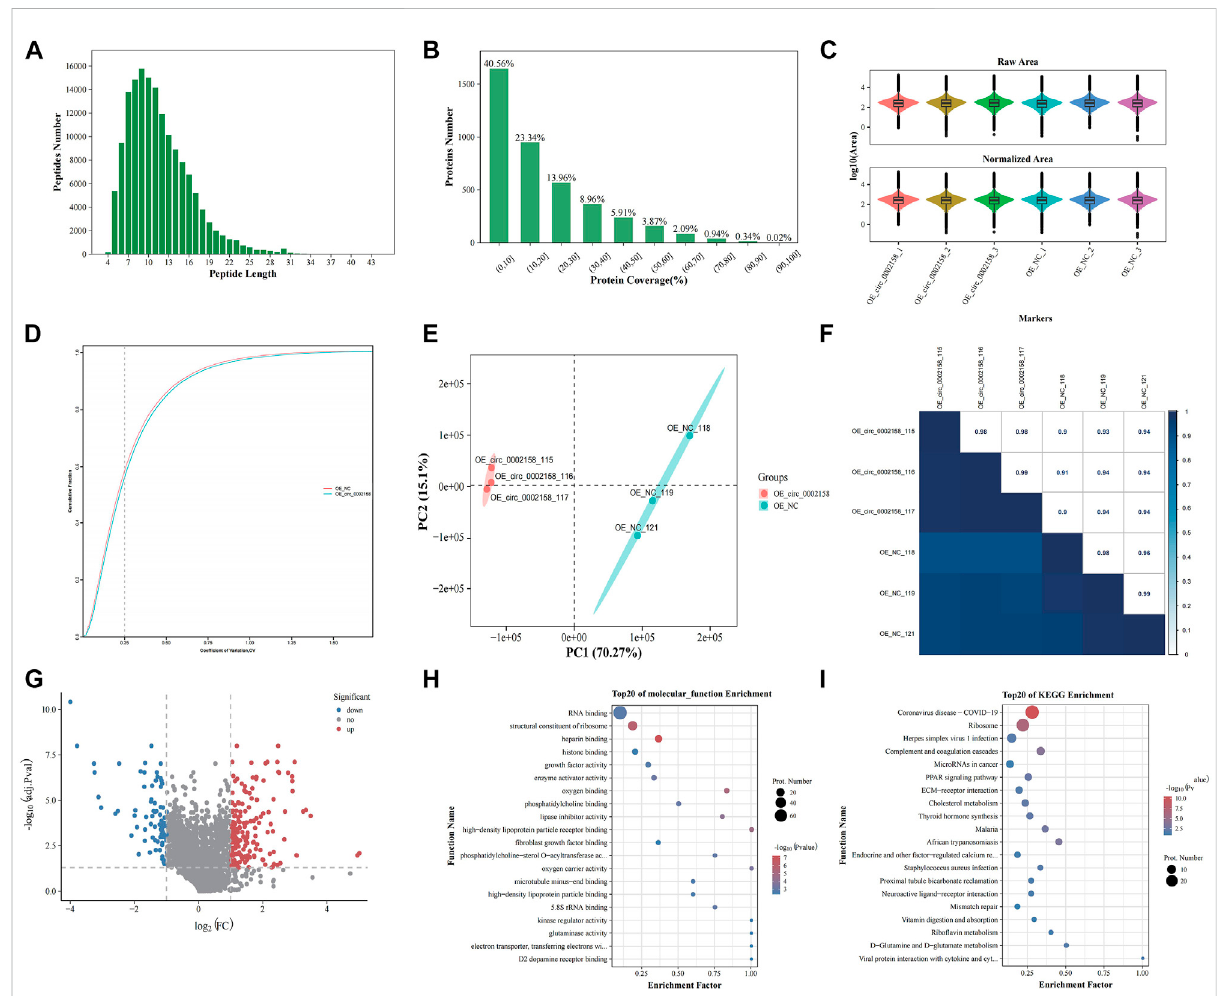
FIGURE 5 iTRAQ proteomics analysis. (A) Length distributions of peptides. (B) Protein identi fi cation coverage distributionmap. (C) Abundance map of the sample. (D) Sample repeatability plot. (E) Principal component analysis plot. (F) Pearson correlation coef fi cient plot for samples. (G) Volcano plots showing the signi fi cant up-regulated and down-regulated differentially expressed proteins (DEPs). Gene ontology (H) and Kyoto Encyclopaedia of Genes (KEGG) terms (I) of host genes from which DEPs were identi fi